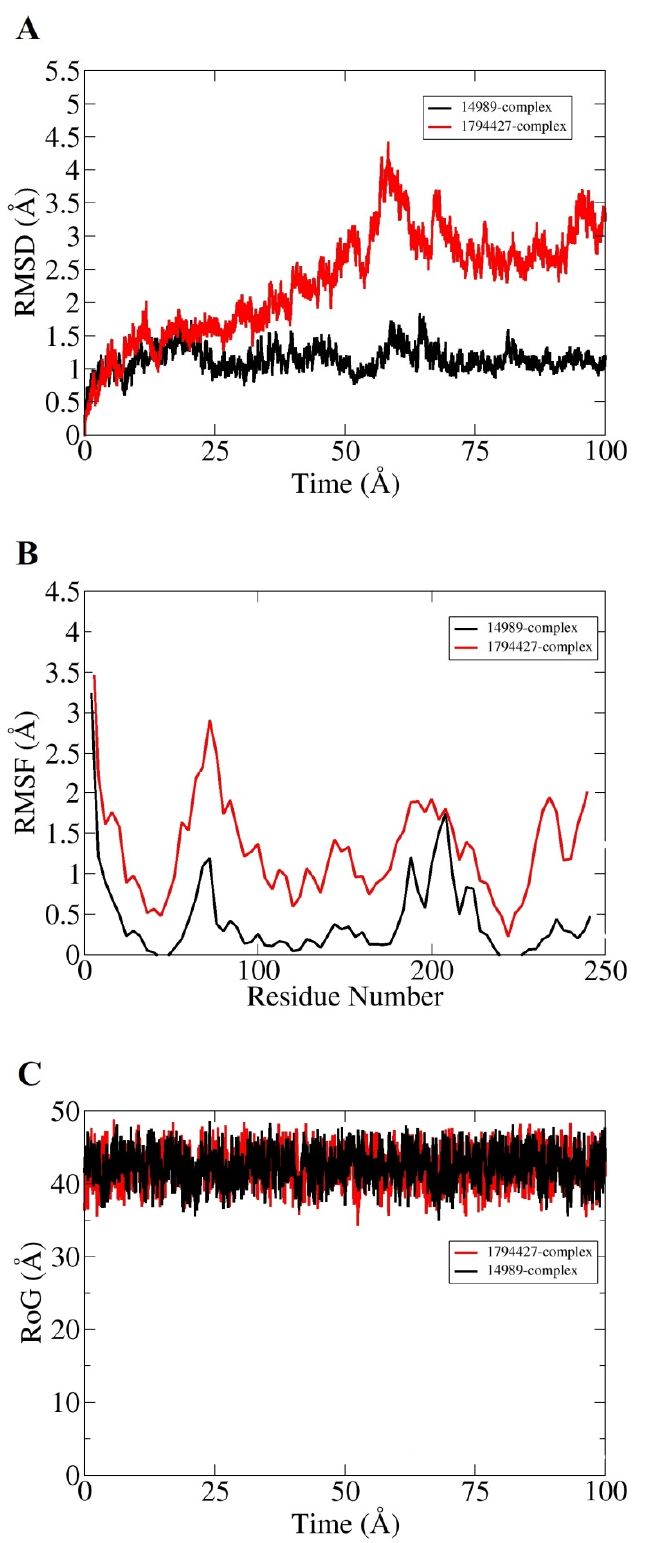
Figure 5. Statistical analysis based on molecular dynamics simulations to assess the intermolecular stability and dynamics of the two complexes of the TCR target proteins. ( A ) part is indicating Root Mean Saquare Deviation for both top compounds similarly; ( B ) part is indicating Root Mean Square Fluctuation; ( C ) part is indicating graph values for Radius of Gyration both hits can be presented in different colors as mention above.